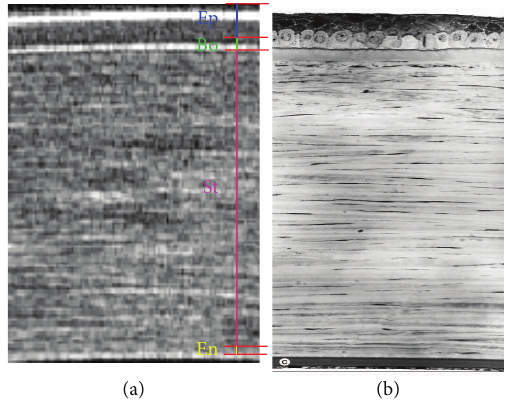
Figure 2: (a) Details of the ROI of Figure 1 with sublayers subdivi- sion: Epithelium (Ep), Bowman (Bo), Stroma (St), and Endothelium (En). The Descemet’s membrane is not reported. (b) Histological sample of a human cornea (the two pictures do not belong to the same